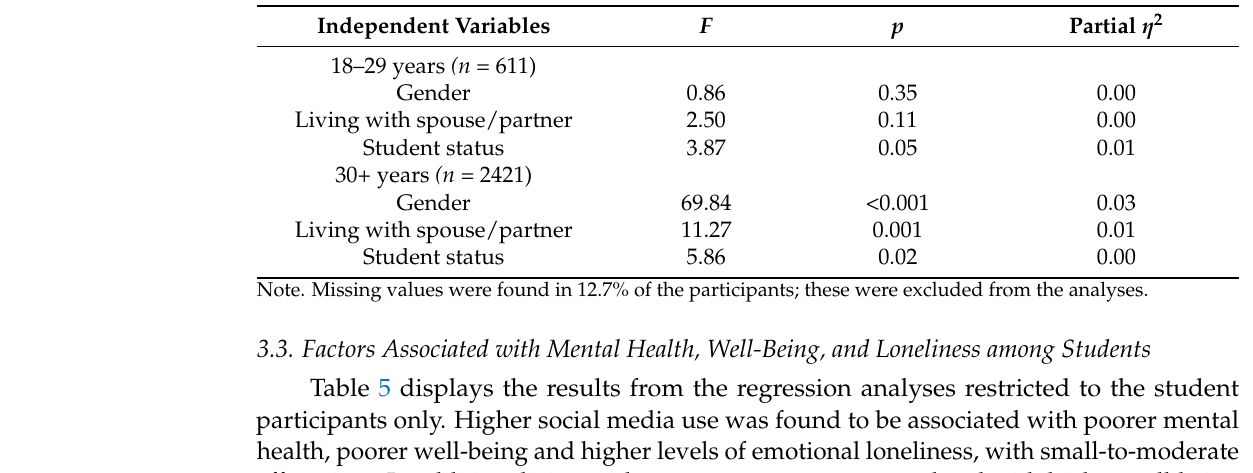
Table 4. Predictors of mental health (GHQ scores) by age group.